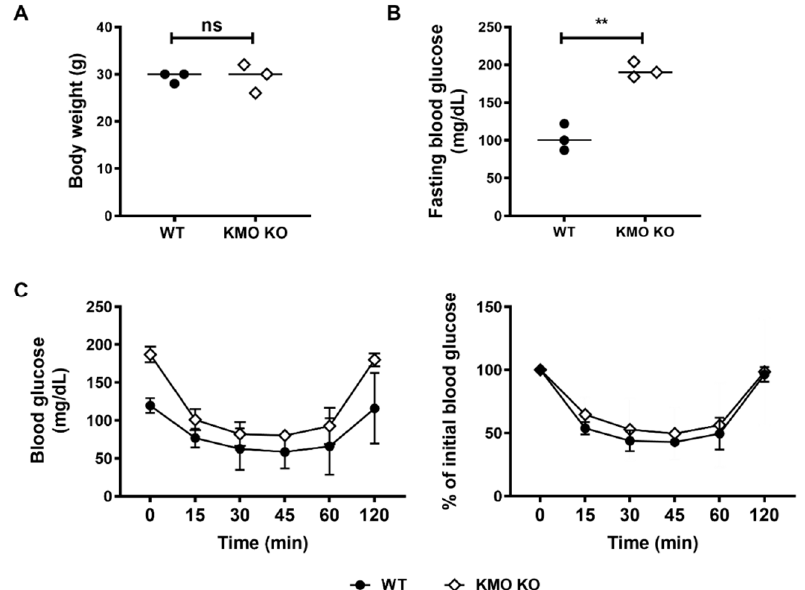
Figure 5. Fasting blood glucose was higher in KMO KO mice than in WT mice, but body weights and insulin tolerance test results were similar. The body weights were similar in WT and KMO KO mice ( A ). Fasting blood glucose (FBG) was higher in KMO KO mice ( B ). The KMO KO mice responded to insulin like the WT mice ( C ). The line graphs represent the means ± SD of triplicate measurements. ns = not significant, ** p < 0.01.